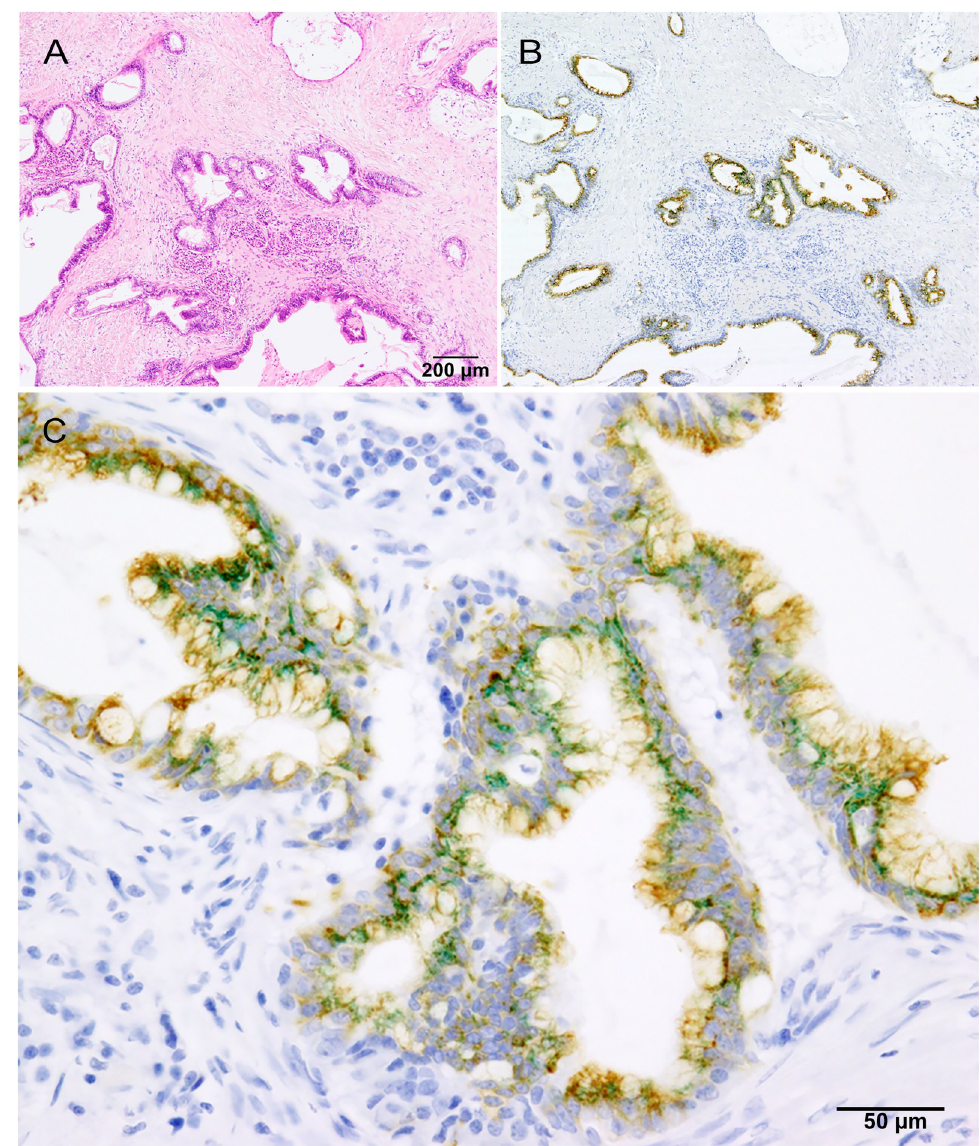
Fig 4. Double immunohistochemistry for β 3Gn-T6 and MUC5AC. Low-power view of histological staining (A) and double immunohistochemical staining (B) and high-power view of double immunohistochemical staining (C). Dotlike staining of β 3Gn-T6 (green) and membranous staining of MUC5AC (brown) are often present in the same adenocarcinoma cells.